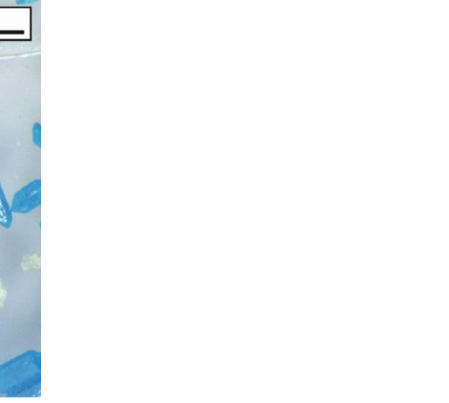
Figure 19. Single crystals of teineite grown by direct contact of a 0.3 m CuCl 2 solution and TeO 2